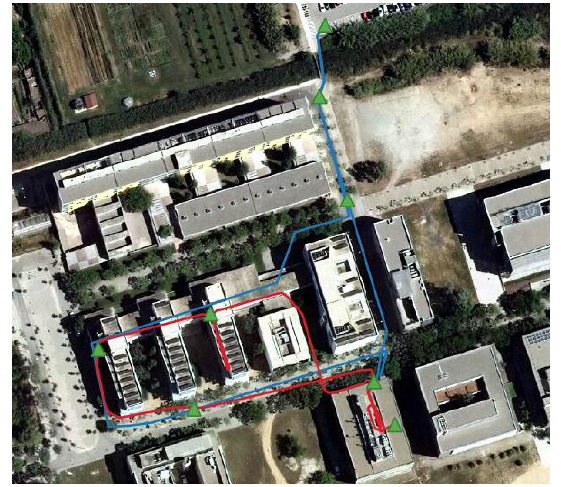
Figure 3. Walking paths for the tests. The GNSS path is shown in blue while the VIO test path is shown in red.